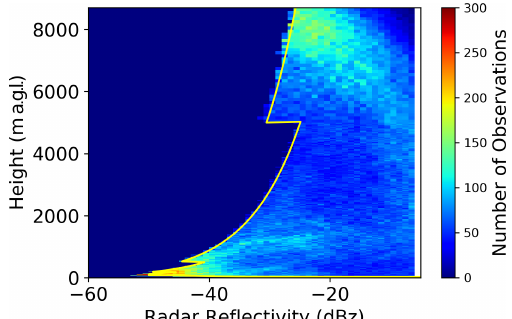
Figure 1. Contour frequency by altitude diagram of the number of observations made by the radar for reflectivity intervals (in dBz). The sensitivity of the instrument is marked by the yellow